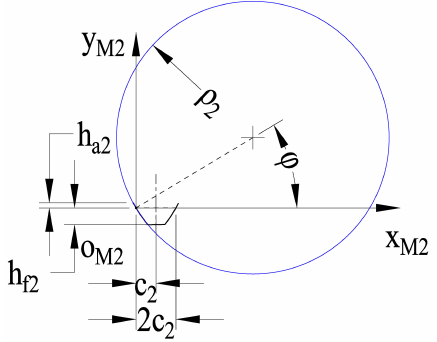
Figure 6. Schematic diagram of the normal tooth profile of the driven line